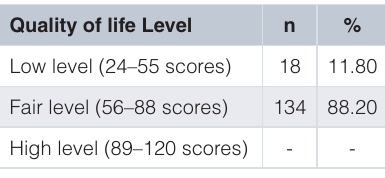
Table 2. Level of quality of life among elderly people (n = 152).